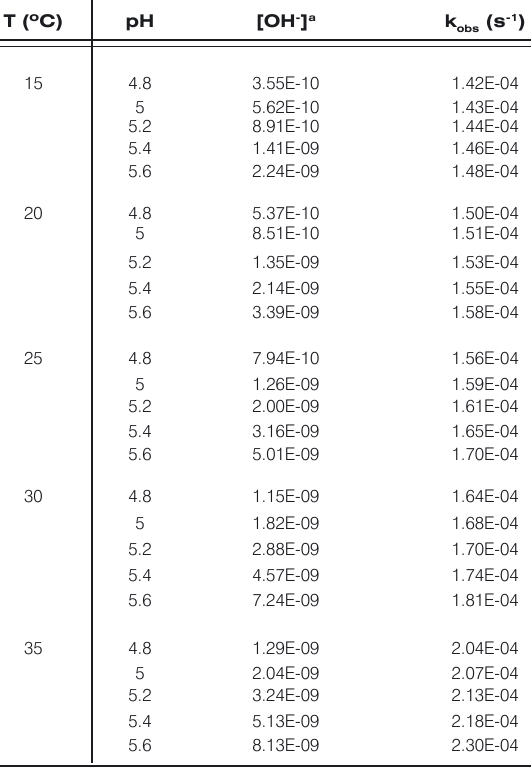
Table 2. Kinetics of the hydrolysis of [Pd(pip)(GlyOMe)] 2+ at different temperatures in aqueous solution and 0.1 M ionic strength. (s -1 ) T (ºC) pH [OH - ] a k obs